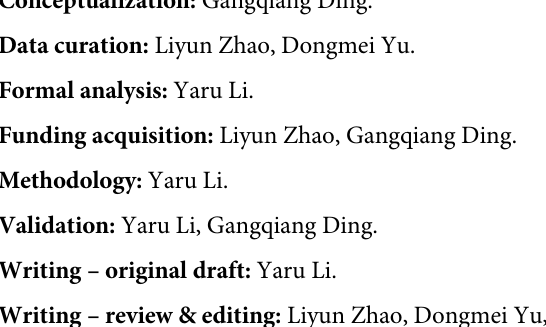
S1 Table. Analysis